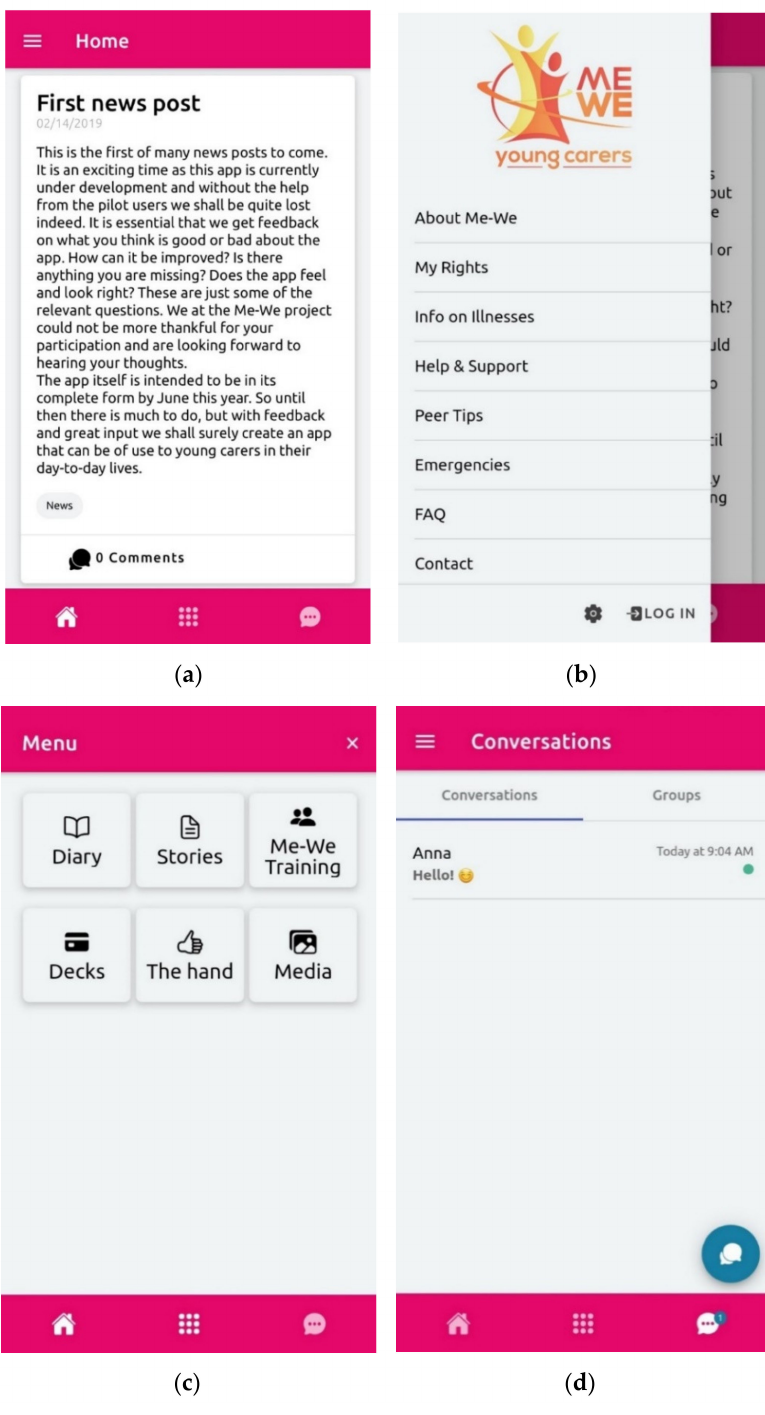
Figure 3. ( a ) ME-WE app: Homepage includes country-specific news and is the first page that appears when a user starts the app. ( b ) ME-WE app: Left menu includes pages with relevant information concerning YCs, a log out/log in button and settings where users can change their username, password, text size, etc. ( c ) ME-WE app: Launchpad menu, a navigation area where the Diary, Stories and the educational resources used in the ME-WE group sessions can be found. ( d ) ME-WE app: The chat where users can send text messages and pictures in either individual conversations or group